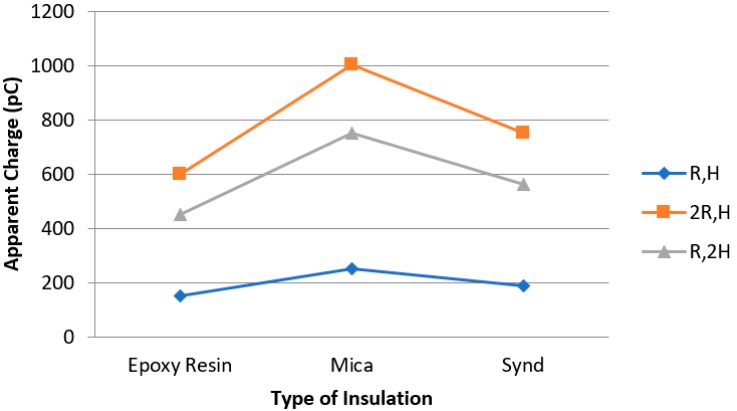
Figure 35. Apparent Charge for the Different Insulation Materials.